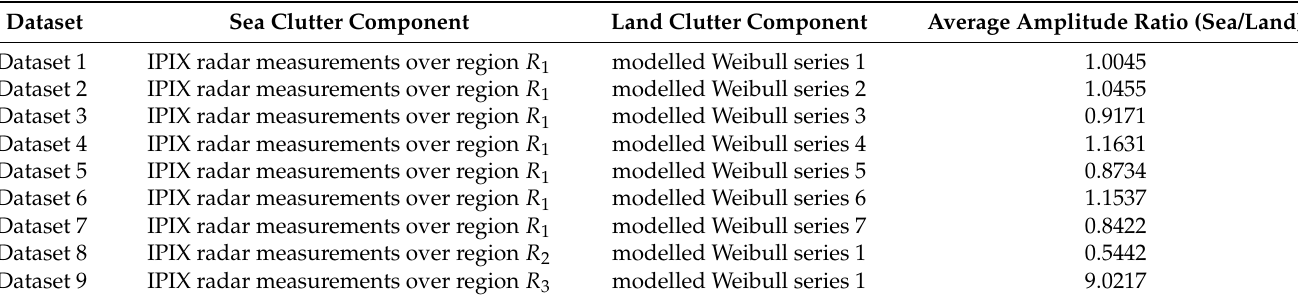
Table 3. The additional nine datasets used to evaluate proposed features.